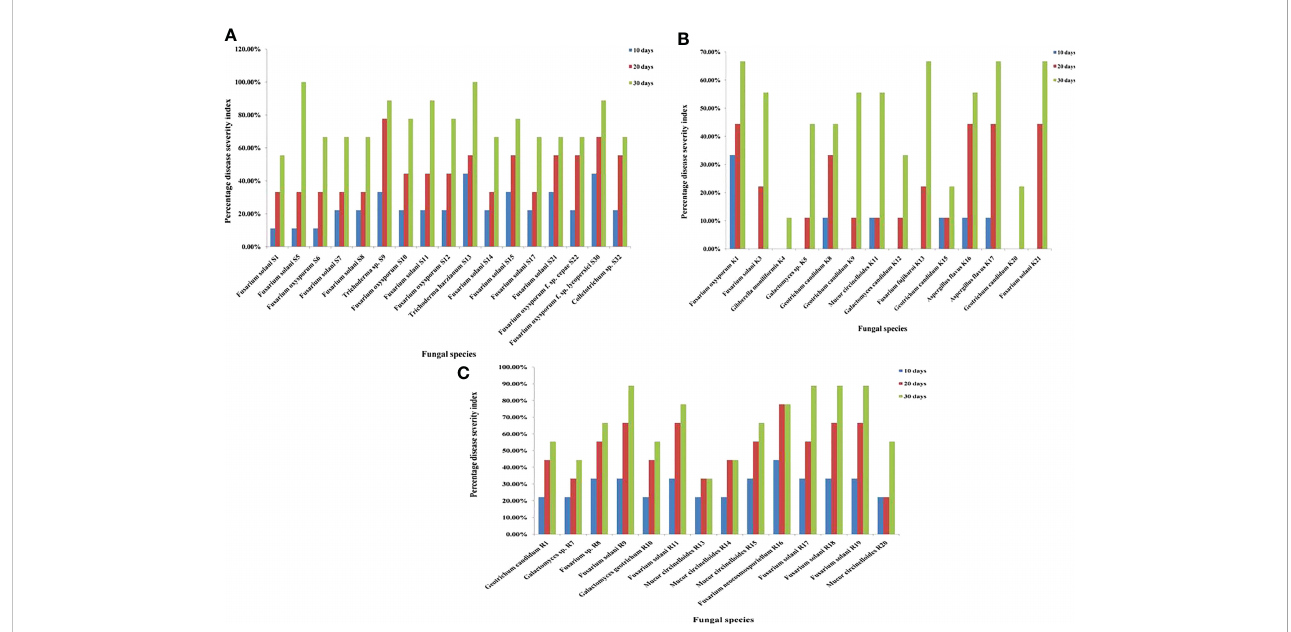
FIGURE 9 (A) Pathogenicity test of fungal species isolated from Srinagar soil on saffron roots at 10, 20, and 30 days post-inoculation (dpi). (B) Pathogenicity test of fungal species isolated from Kishtwar soil on saffron roots at 10, 20, and 30 dpi. (C) Pathogenicity test of fungal species isolated from Ramban soil on saffron roots at 10, 20, and 30